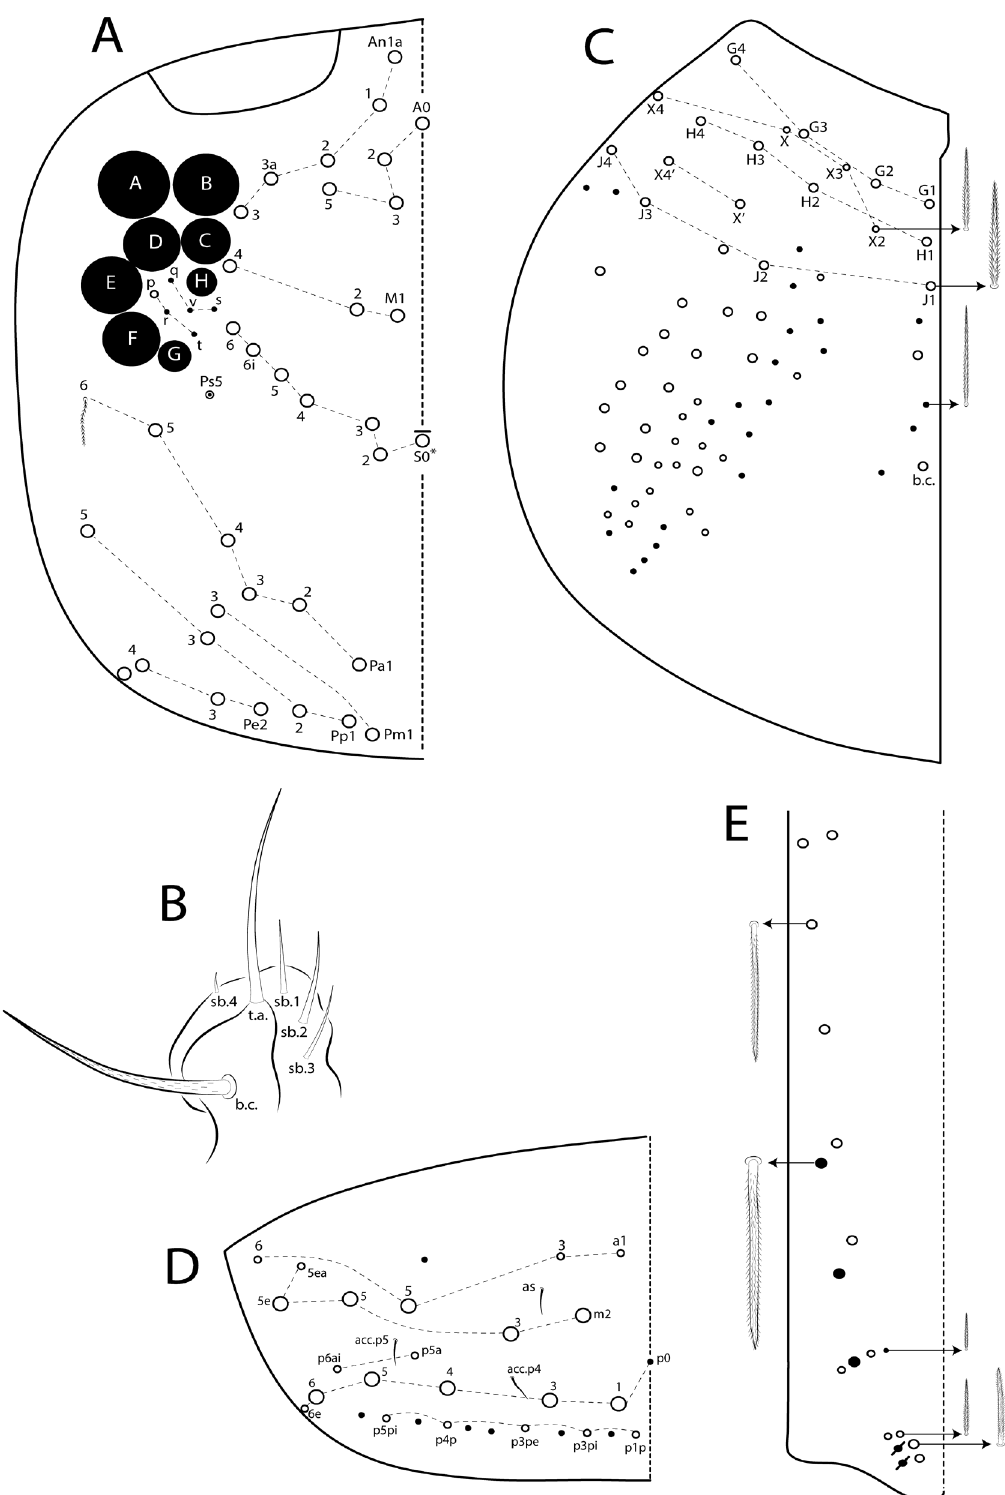
Fig. 9. Willowsia neonigromaculata sp. nov., body parts (left side). A . Cephalic dorsal chaetotaxy. B . Maxillary outer lobe. C . Complete postlabial chaetotaxy. D . Abd V dorsal chaetotaxy. E . Manubrium dorsal chaetotaxy. Abbreviations: see Material and